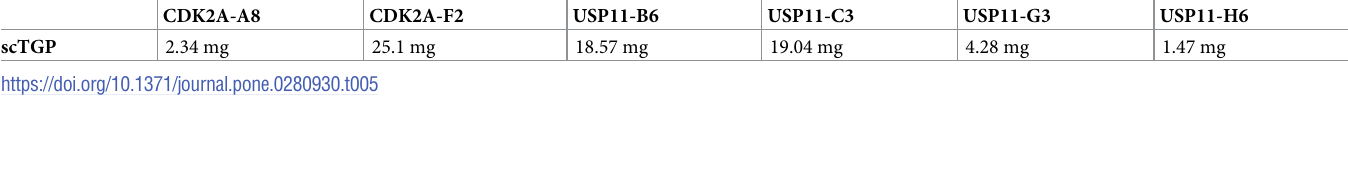
Fig 5. Expression level comparison and binding characteristics of selected scTGPs. a) data on E . coli based protein expression from various scTGP clones. The fluorescence signal obtained from soluble protein present in 100 ml of pop culture supernatant obtained from 2mL growth cultures are compared. The experiment was performed in triplicate and standard deviation is shown as error bars. Antigen binding data for the scTGPs displayed on yeast, b ), and in the purified protein format using FLISA, c) . The CDK2A and USP11 antigens are used as cross specificity controls for all six scTGPs (x-axis) and fluorescent signal obtained upon binding is shown on y-axis. The binding assays were performed in triplicate and the average and standard deviation (error bars) are shown.